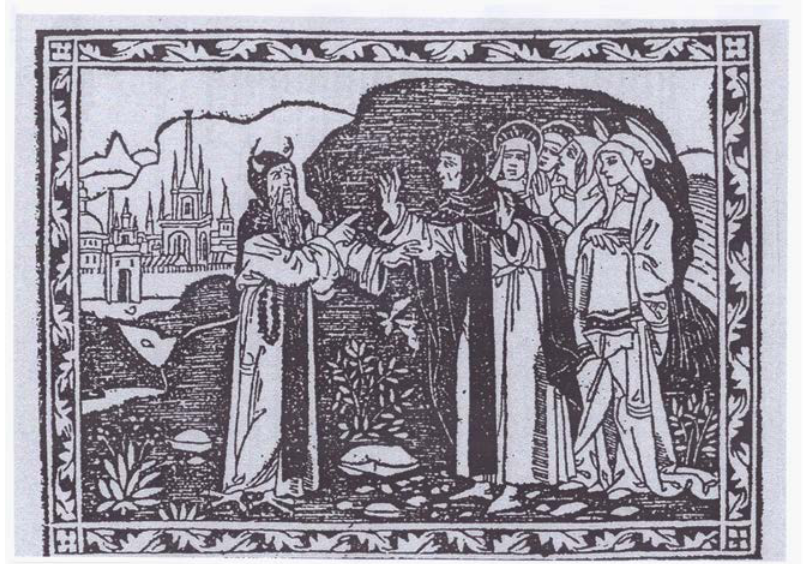
Figure 10 – Girolamo Savonarola, Compendio di rivelatione , ad instantia di ser Piero Pacini da Pescia, Firenze 23 aprile 1496, f. 11v (BNCF, Sav. 146). By permission of Ministero per i beni e le attività culturali / Biblioteca Nazionale Centrale. Firenze